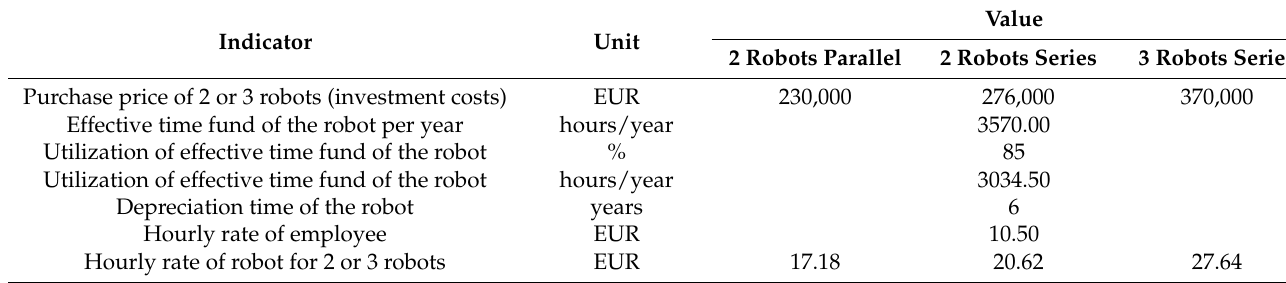
Table 10. Input data for calculating the hourly rate of the